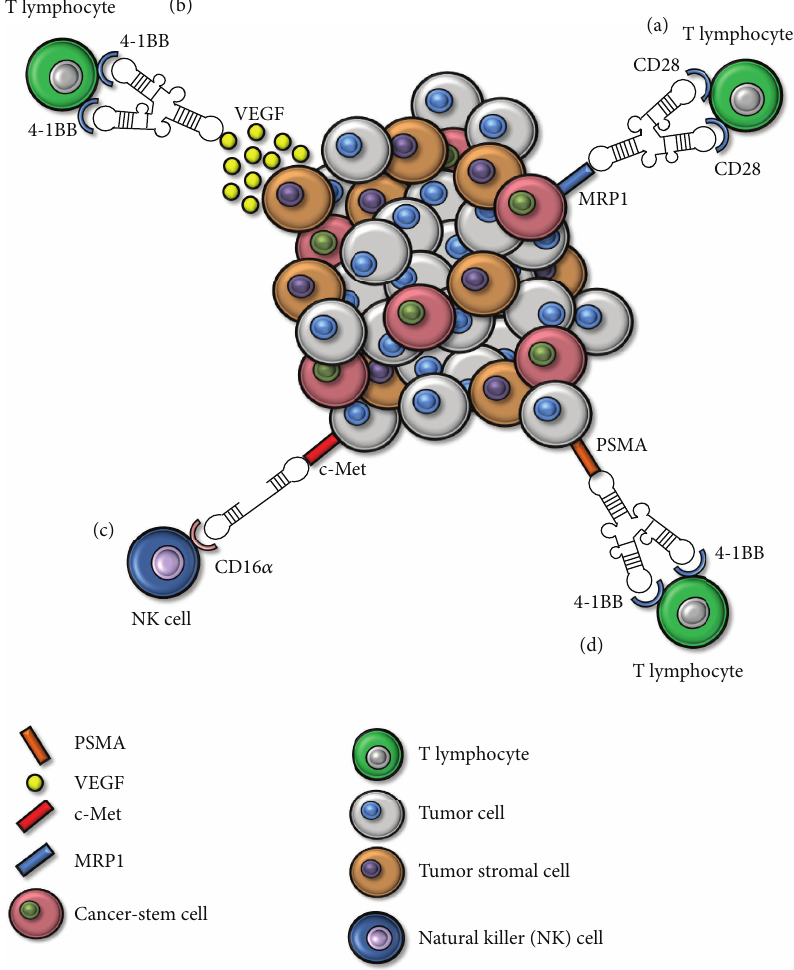
Figure 3: Bispecific aptamers used to date in cancer immunotherapy. (a) Bispecific aptamer CD28-MRP1. (b) Bispecific aptamer 4-1BB-VEGF. (c) Bispecific aptamer CD16 𝛼 -c-Met. (d) Bispecific aptamer